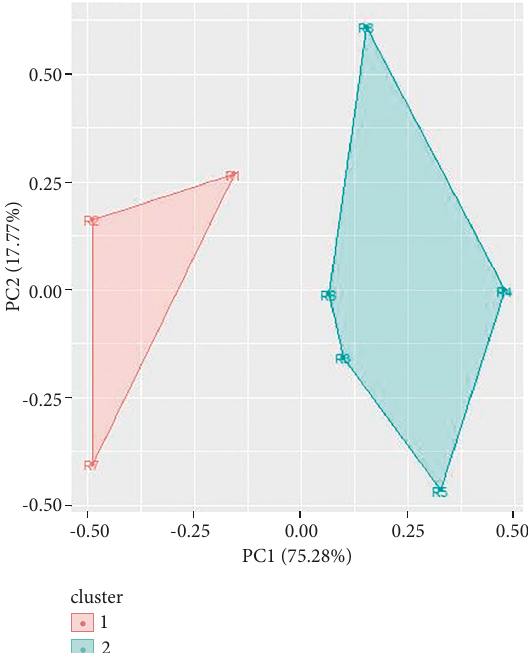
Figure 15: Cluster analysis for FTIR spectroscopy data for red ballpoint pen inks.